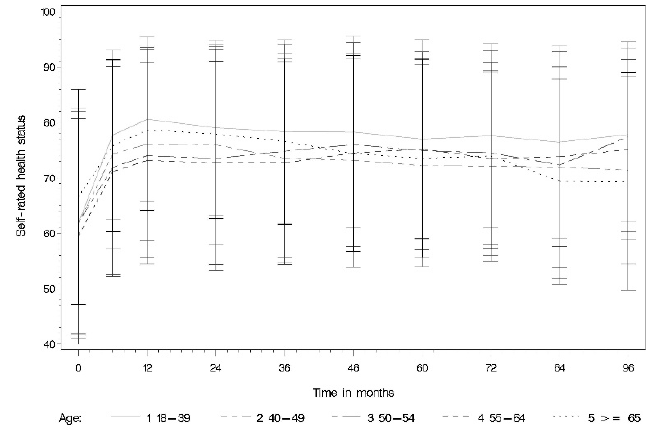
Figure 2: Self-rated health status over time Conclusions: Higher mortality in older recipients complies with data from the general population. The non-linear relationship between age and graft loss and the higher scored self-rated health status at all follow- up time-points compared to the pre-transplant status -regardless of age- highlight that age alone might not be an accurate measure for risk pre- diction and clinical decision making in kidney transplantation. Exploring other independent predictors, such as frailty as an indicator for biological age should be